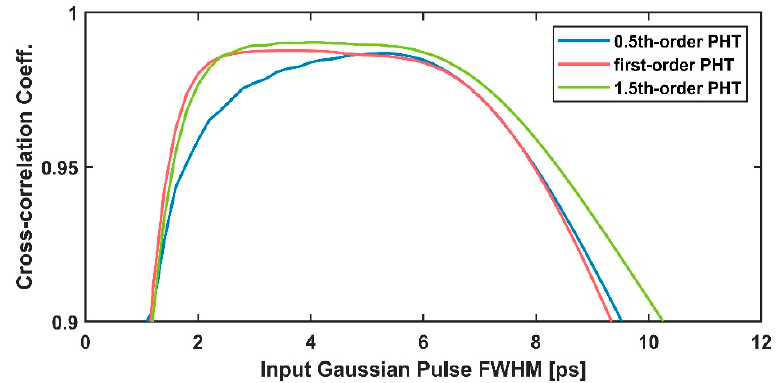
Figure 7. Cross-correlation coefficients between the ideal and numerically obtained temporal output waveforms as a function of the FWHM of the input Gaussian pulse for the three designed PHTs.